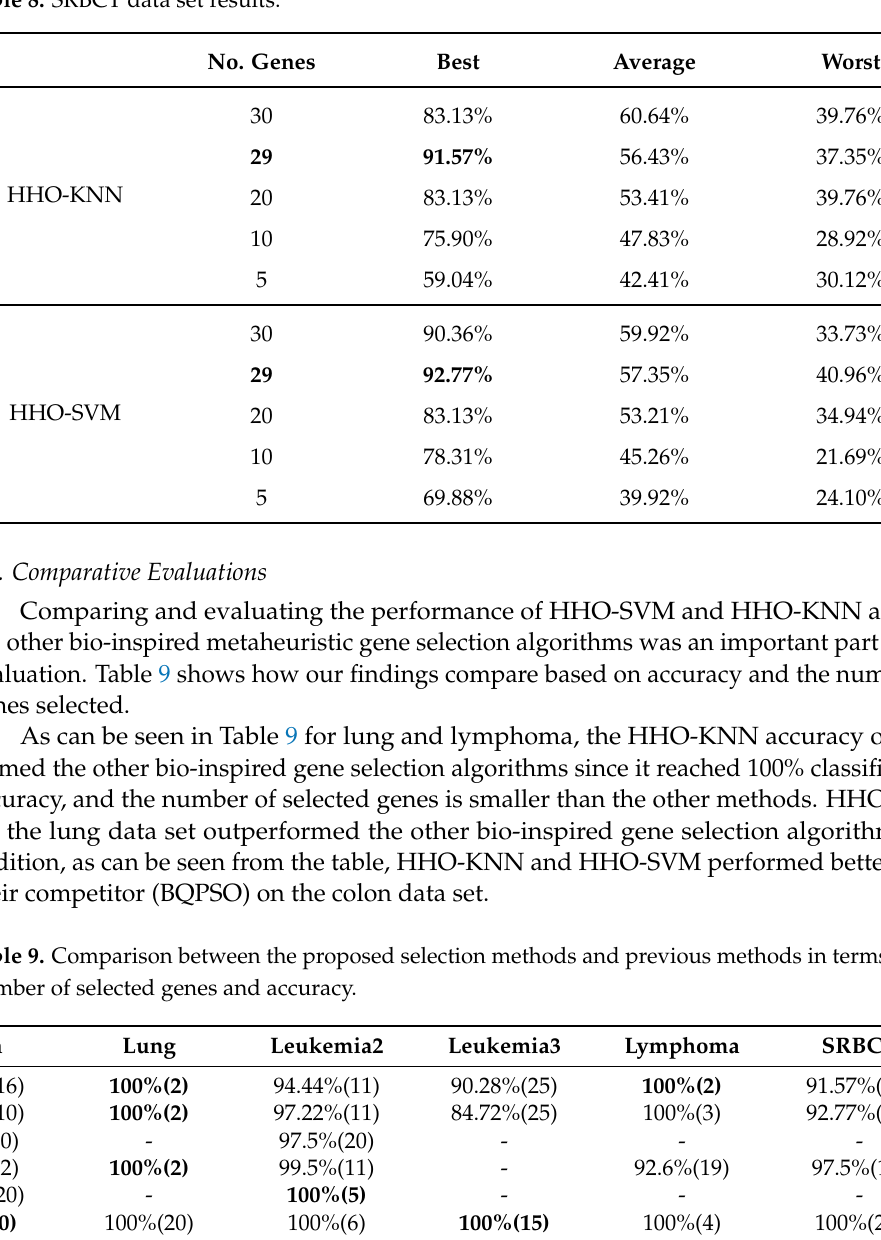
Table 8. SRBCT data set results.